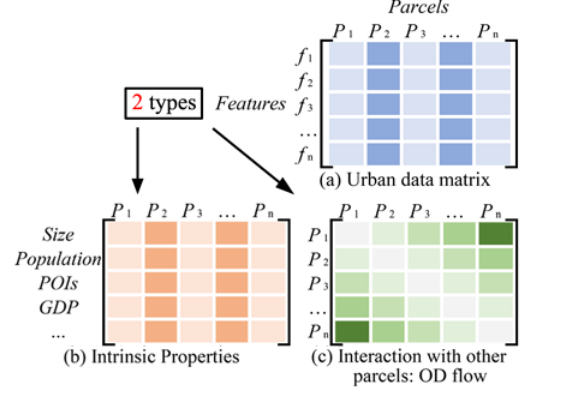
Figure 1. Urban data matrix (a): information of parcels is stored in arrays and thus the urban data matrix is formed. There are 2 types of urban data matrix. One is to describe intrinsic properties of parcels (b) and the other one is to describe the interaction among parcels (c).